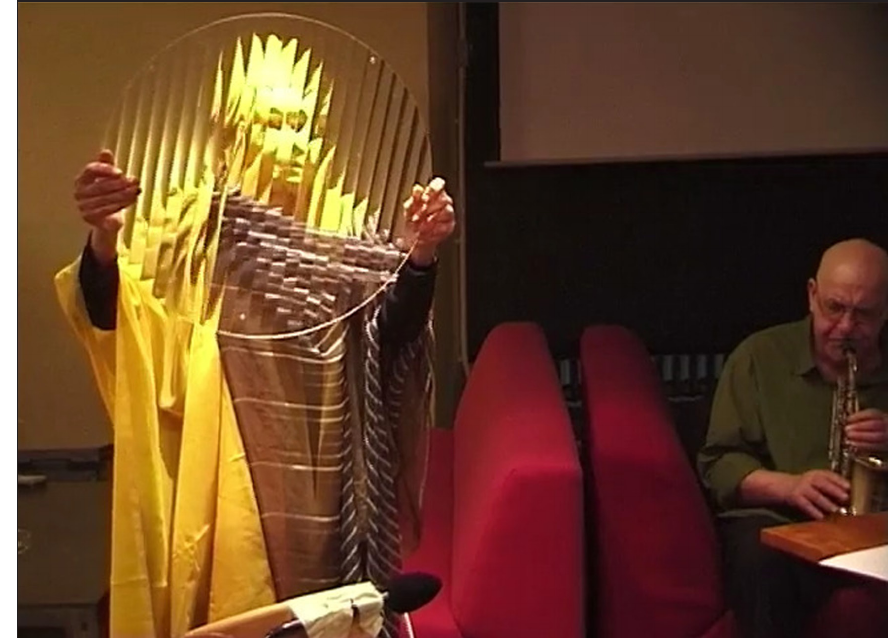
Figure 1.3: (24.38) Jennifer Pike and Lol Coxhill with Birdyak at the RCA, London 2002. Courtesy of William Cobbing, Maddie Coxhill and Ulrike